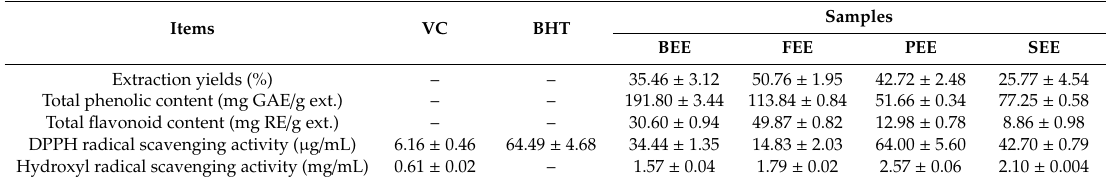
Table 1. Extraction yields, total phenolic, and total flavonoid contents, and antioxidant activities (IC 50 values) of Paeonia su ff ruticosa